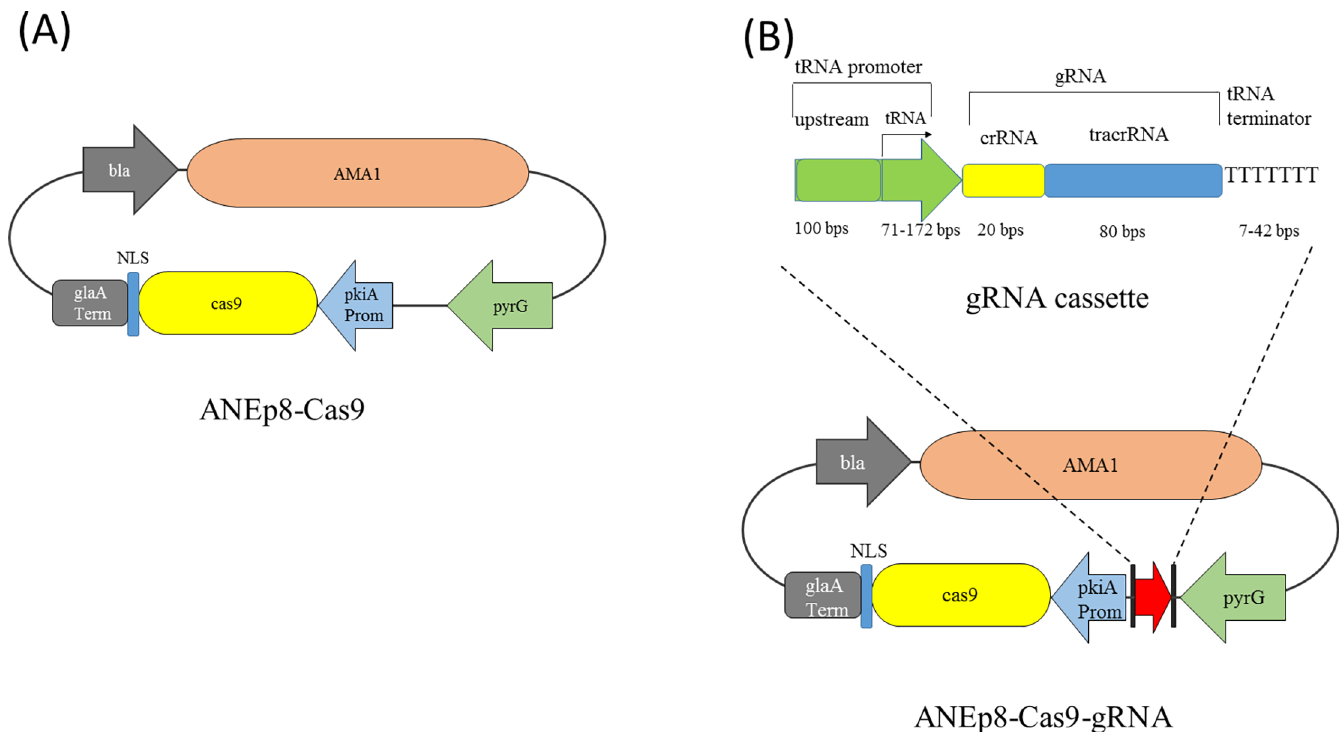
Fig 1. The schematic representation of tRNA-driven CRISPR/Cas9 system adapted for A . niger . (A) The ANEp8-Cas9 plasmid used to express cas9 gene. (B) The construct of gRNA cassette and the ANEp8-Cas9-gRNA plasmid bearing both gRNA cassette and cas9 gene. The tRNA promoter is composed of a tRNA gene and 100 bp upstream sequences. Arrow indicates the start site of transcription. Abbreviations: bla , beta-lactamase gene conferring ampicillin resistance; pkiA Prom, promoter of the pyruvate kinase gene; glaA Term, terminator of the glucoamylase gene; NLS: nuclear localization signal.